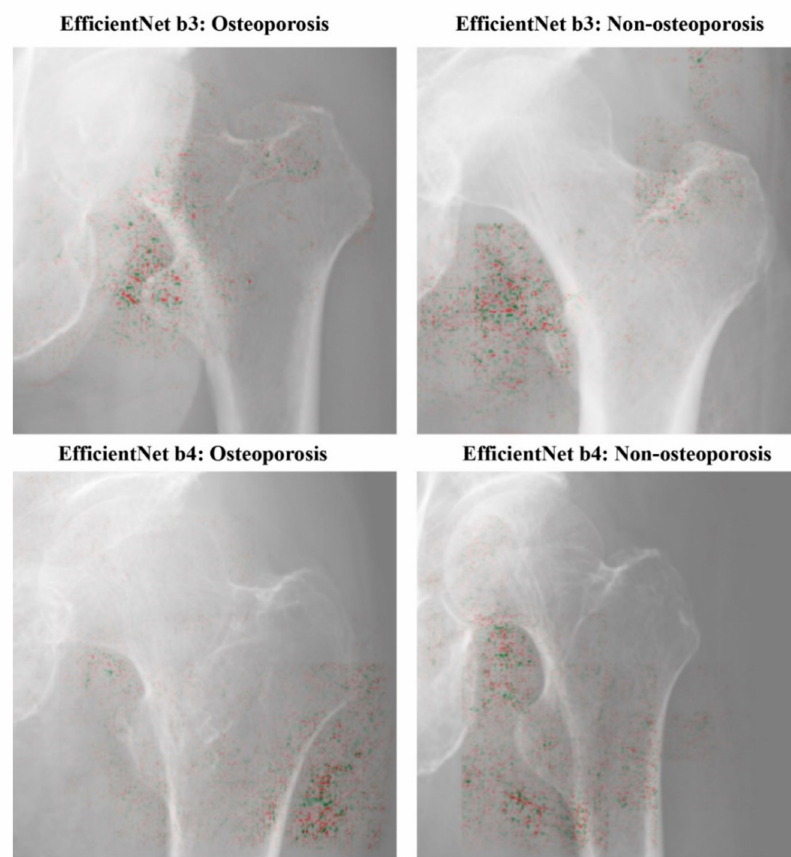
Figure 4. Visualization of characteristic regions of radiographs of osteoporosis a non-osteoporosis patient images on E ffi cientnet b3 and